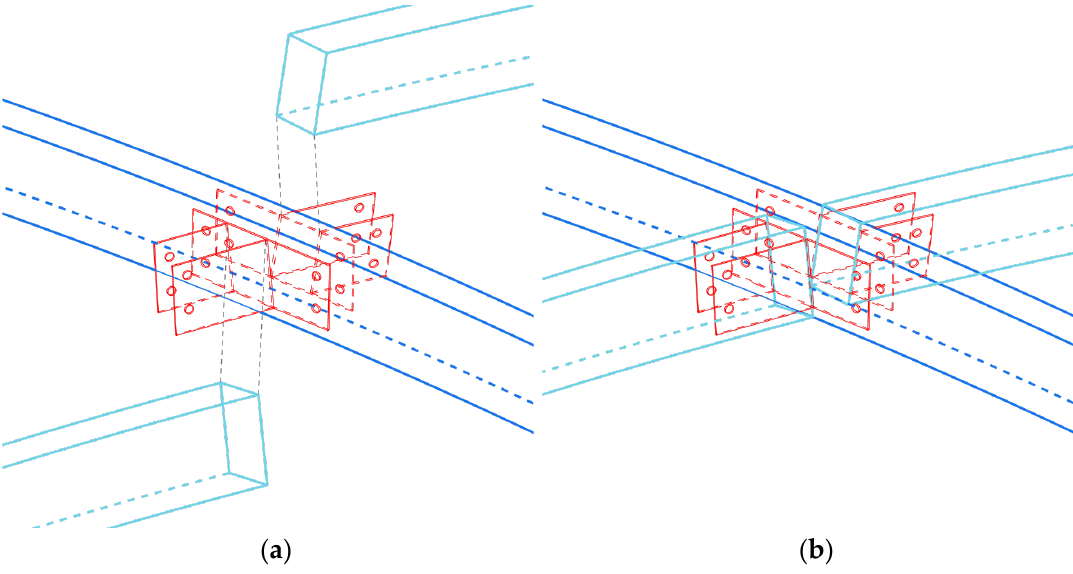
Figure 11. Axonometric view of the designed joint. ( a ) Exploded and ( b ) connected axonometric view.